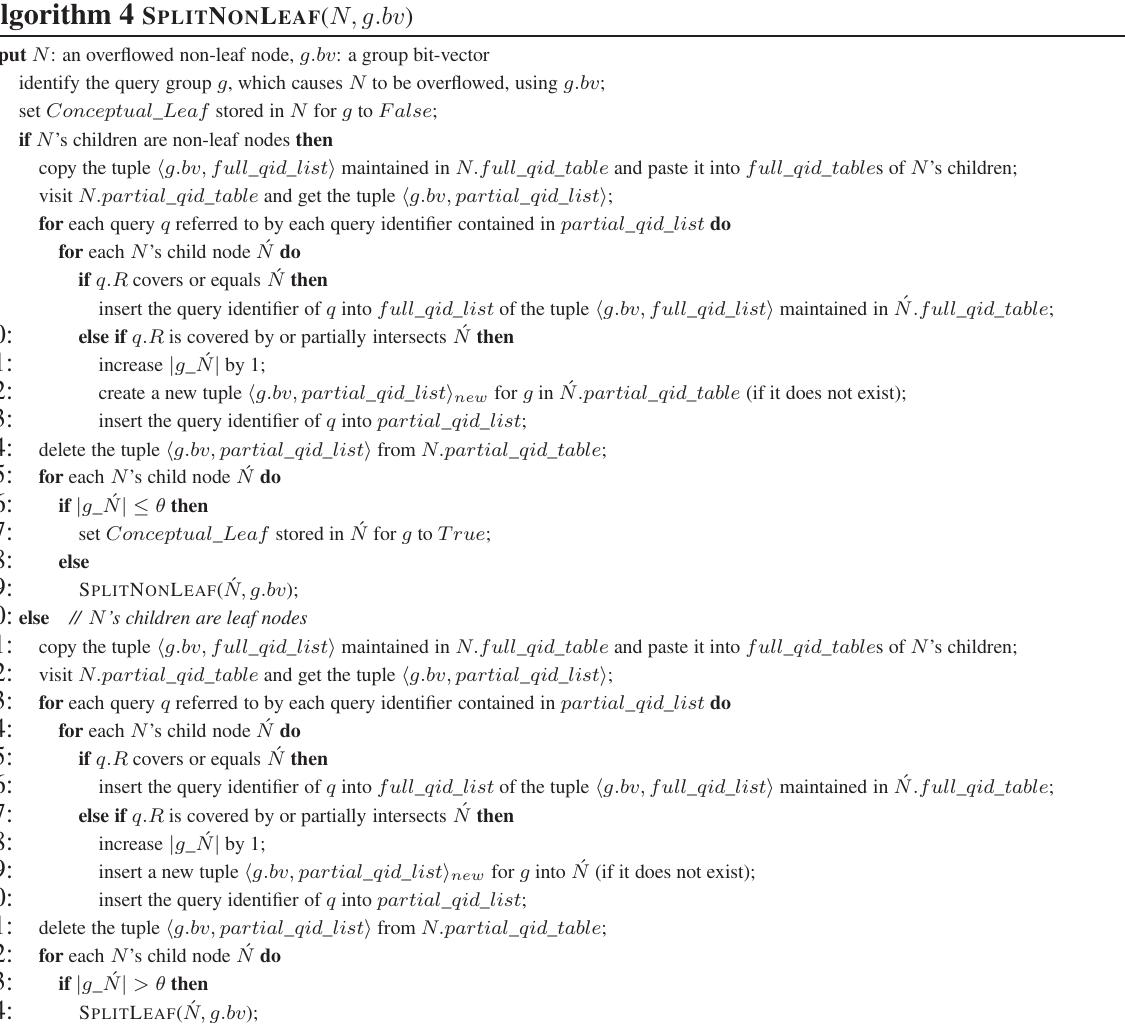
Algorithm 4 S PLIT N ON L EAF ( N, g.bv )